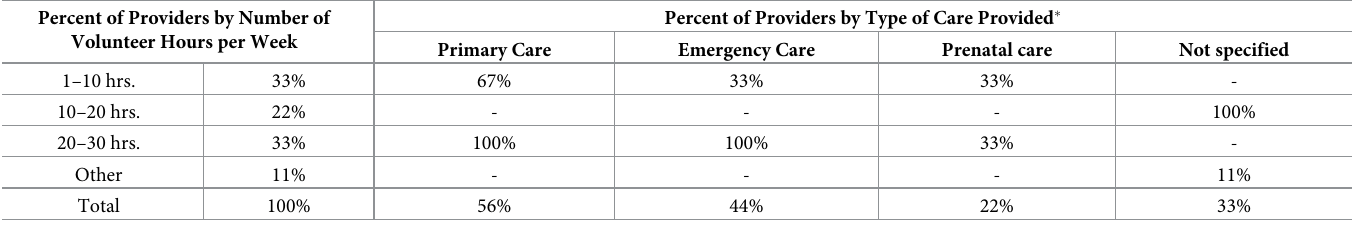
Table 1. Average hours per week contributed by volunteer providers and type of care provided to care for asylum seekers and refugees entering El Paso, Texas (n = 75). Percent of Providers by Number of Volunteer Hours per Week